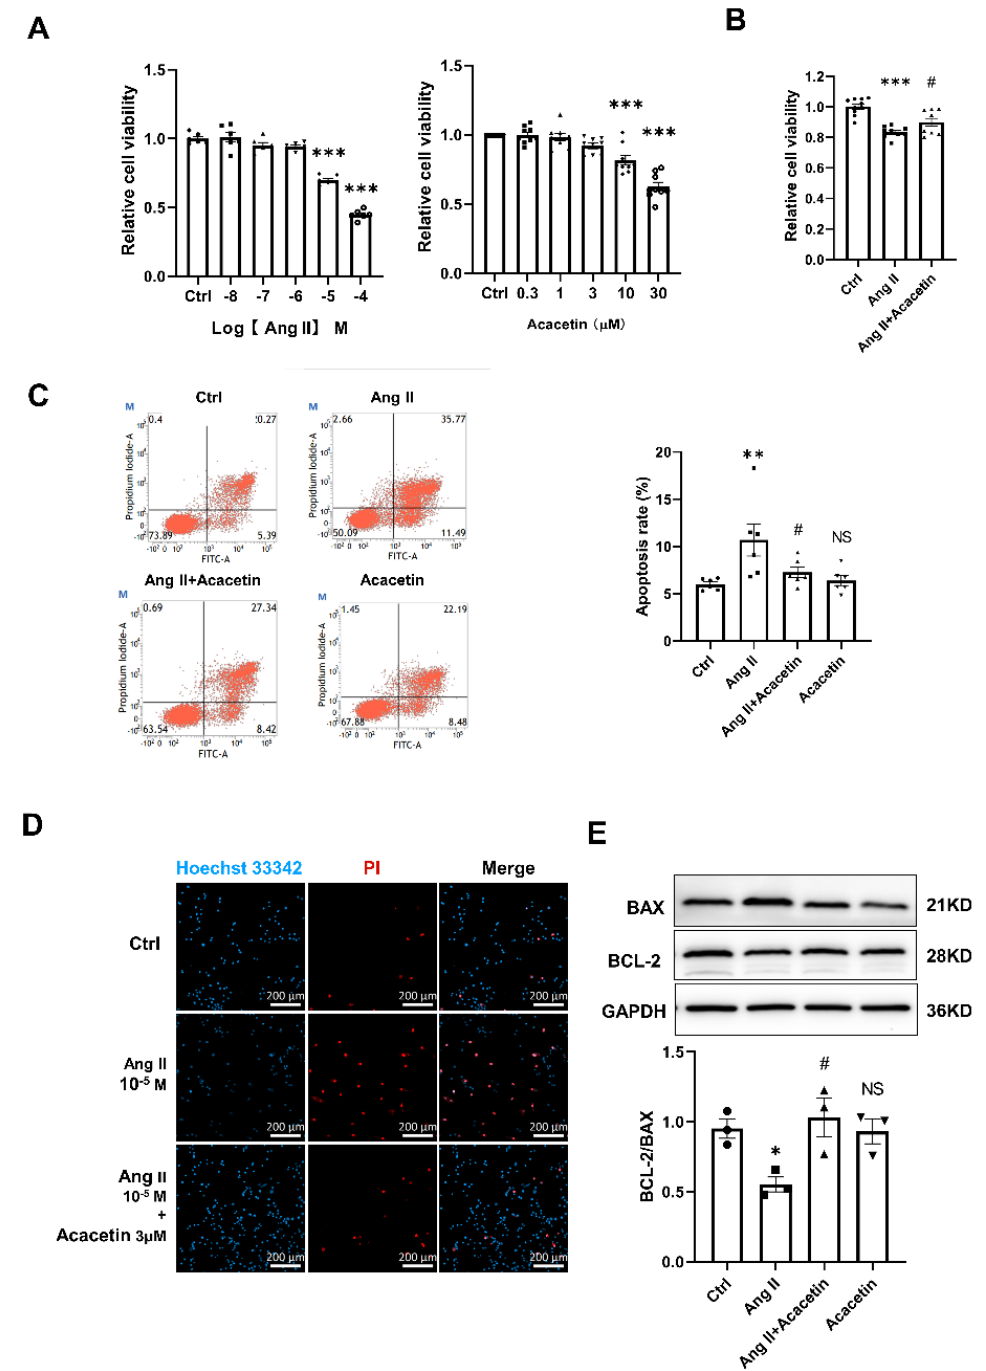
Figure 5. Acacetin inhibited the apoptosis of Ang II–induced HUVECs. ( A ) Cell viability was assayed by CCK8 reagents after incubation with different concentrations of Ang II (1 × 10 − 8 to 1 × 10 − 4 M) or acacetin (0.3 to 30 µ M) for 48 h ( n = 6 for each group). ( B ) Acacetin (3 µ M) inhibited the decrease of cell viability induced by Ang II (10 µ M) ( C ) Two–parameter dot–plots showed the cell apoptosis determined by annexin V–FITC and PI binding measured by flow cytometry. The percentage of annexin V–positive cells in each treatment was indicated in the bottom right–hand corner of each panel. ( D ) Representative nuclear staining with PI and Hoechst 33342 (Hoechst). Scale bar = 200 µ m. ( E ) Western blot analysis showed the protein expression of BCL-2 and BAX in different groups (* p < 0.05, ** p < 0.01, *** p < 0.001 vs. control, # p < 0.05 vs. Ang II group. One-way ANOVA with Bonferroni post hoc test was used for group comparisons).